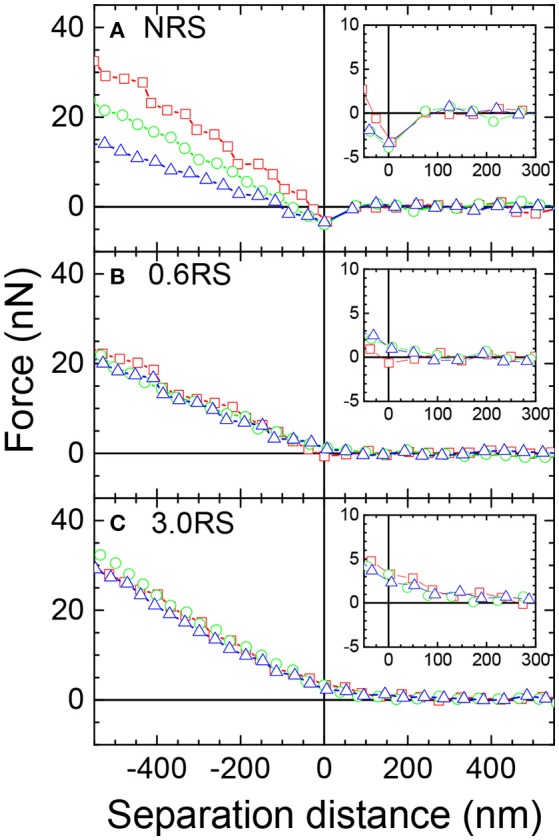
Example approach force curves between a starch particle (probe) in the water phase and a bare air/water interface or a starch film at an air/water interface, where the same particle type used to prepare the films was used as the probe. Red open squares: starch particle film compressed to Π = 5 mN/m; green open circles: starch particle film compressed to Π = 10 mN/m; blue open triangles: starch particle film compressed to Π = 15 mN/m. The insets show the force vs. separation distance curves on a magnified scale, showing the shift from the attraction to repulsion more clearly.